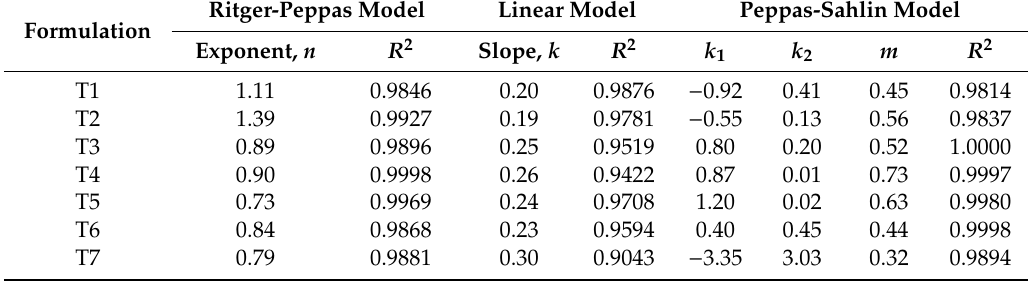
Table 2. In vitro dissolution parameters for the 3DP tablets.